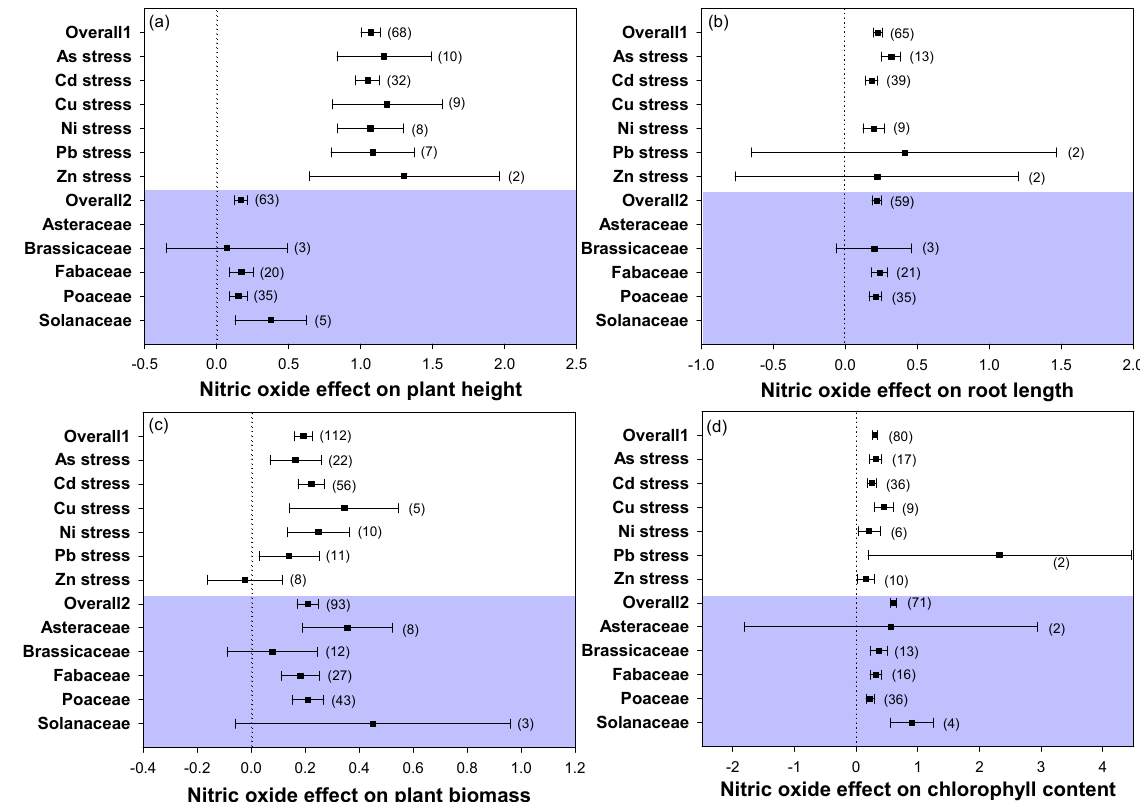
Figure 1. Plots of effect sizes for the effect of NO on ( a ) plant height, ( b ) root length, ( c ) plant biomass, and ( d ) chlorophyll content. Overall1 and overall2 indicate the mean (summary) effect size of all heavy metal stresses and plant families, respectively. The numbers in brackets specify the number of data points. The black square block with the error bar indicates the mean response size with a 95% confidence interval, and the dashed vertical line shows zero